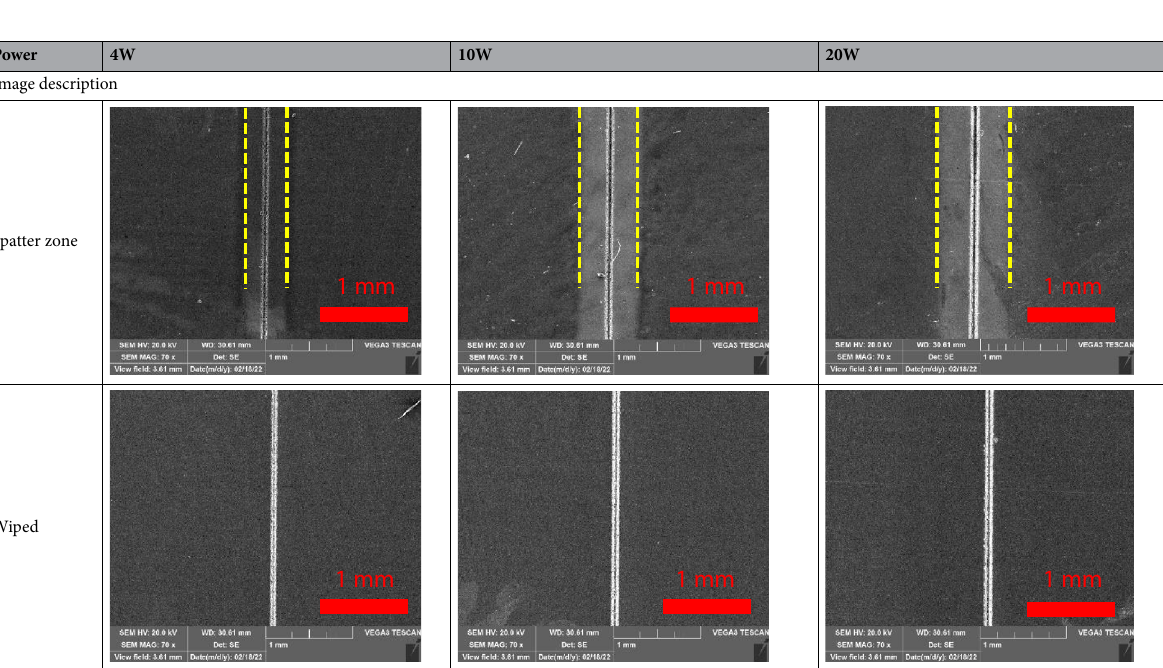
Figure 6. Effect of power on physical morphology; ( a ) 4W, ( b ) 10W, ( c ) 20W [Fixed: 20 k Hz, 200 ns, 100 mm/s and 1pass].